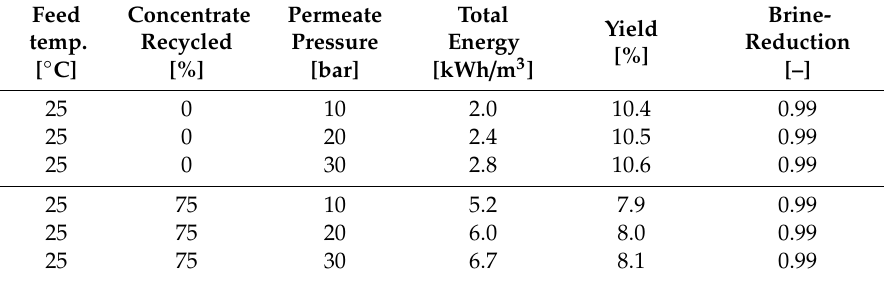
Table 12. Optimized results of SW30XLE-440i membrane at 10 ◦ C. Feed